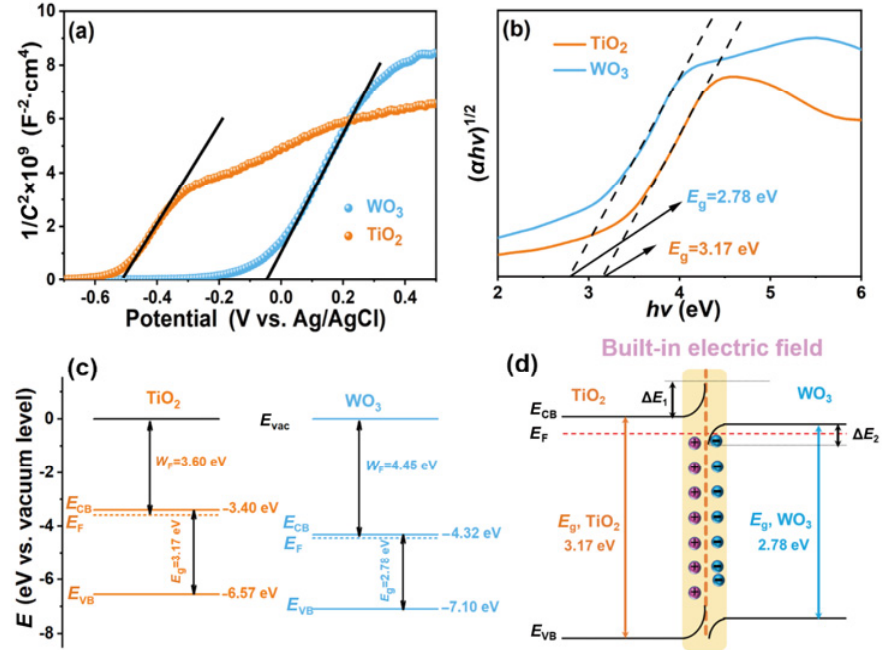
Fig. 5 Mott–Schottky plots (a), Tauc plots (b), and energy band alignment (c) of both TiO 2 and WO 3 . Schematic illustration of the heterojunction formed at the TiO 2 /WO 3 interface